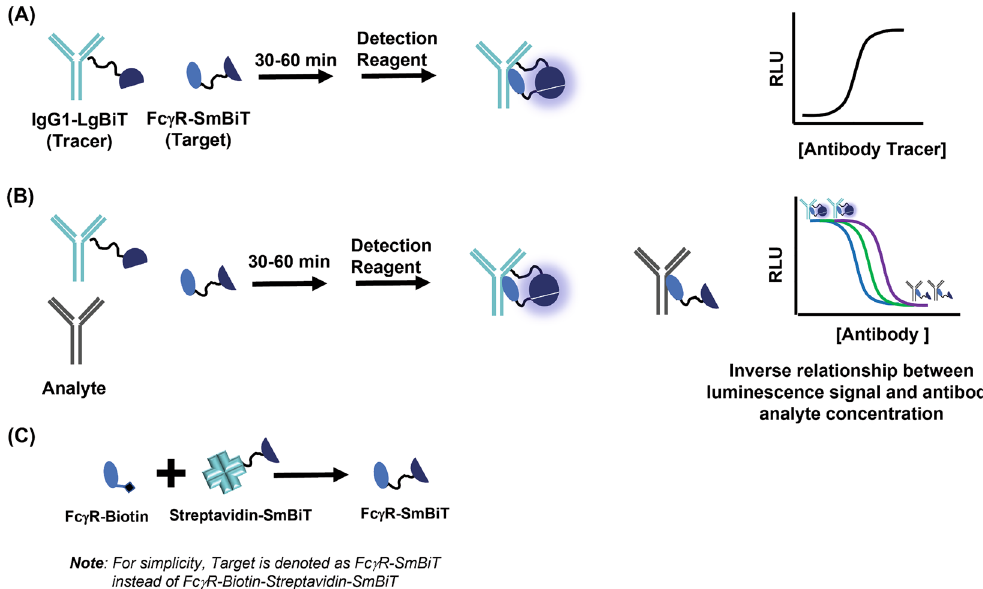
Figure 1. Schematic showing development of NanoBiT FcγR immunoassay. ( A ) Tracer-Target binding assay is performed to determine their optimum amount and provide IC 50 values that are equivalent to dissociation constant (K D ). ( B ) Workflow of the NanoBiT FcγR competition assay to calculate IC 50 values of the analyte. ( C ) Modular approach to the formation of various FcγR-SmBiT tracer by combining biotinylated FcγR with